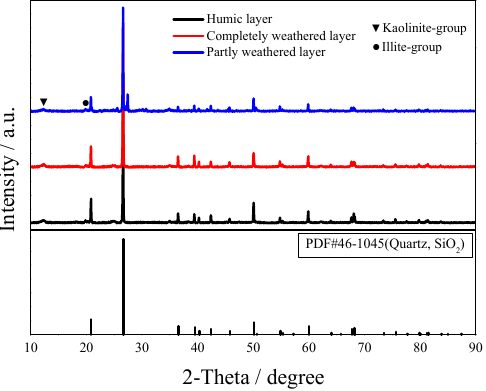
Figure 2. The XRD pattern of rare earth ore.